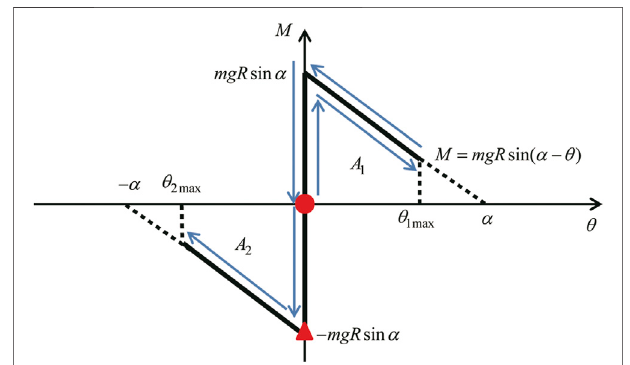
FIGURE 4 | Moment-rotation relation for rocking response of rigid block and timing ofimpulses (red solidcircle isthe fi rst impulse and red solid triangle is the second impulse) (Nabeshima et al., 2016).